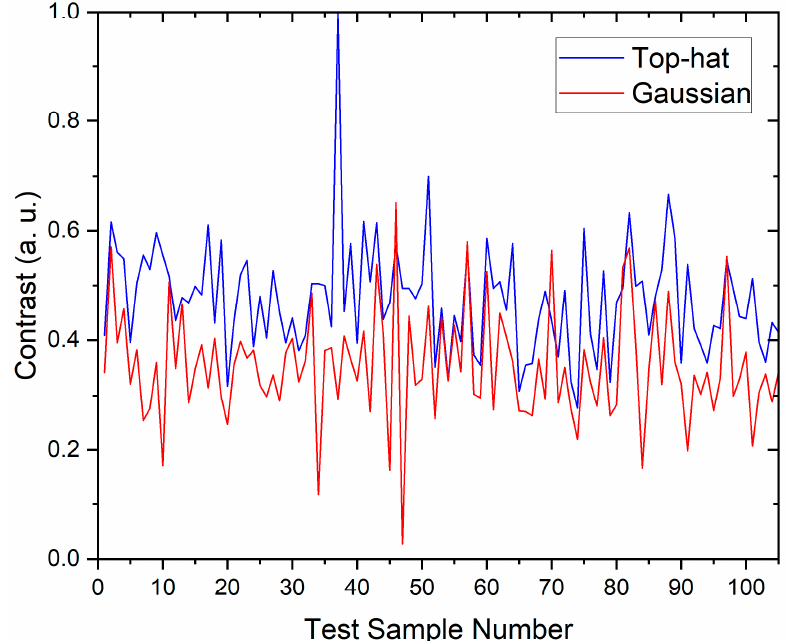
Figure 8. A plot of the contrast values for the 100 reconstructions on random samples conducted with top-hat and Gaussian